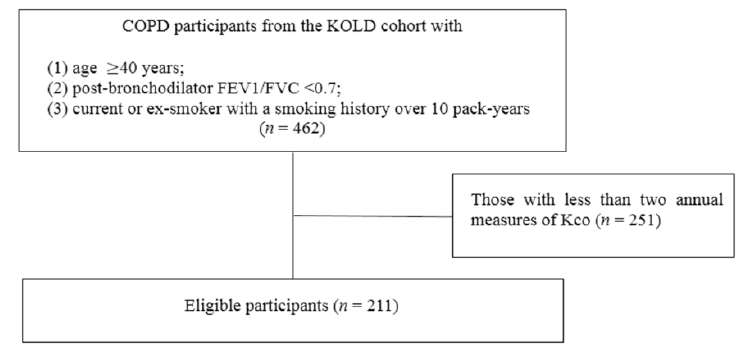
Figure 1. Flow diagram of the study design.